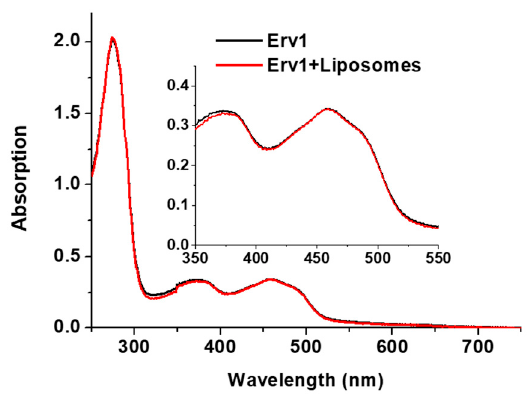
Figure 3. UV-vis absorption spectra of Erv1 in the absence (black) and presence (red) of 0.5 mM CL15 liposomes. The same overlapping spectra were obtained for Erv1 in the presence of CL0 or CL5 liposomes (data not shown). The molar ratio of lipids:Erv1 was 60:1.